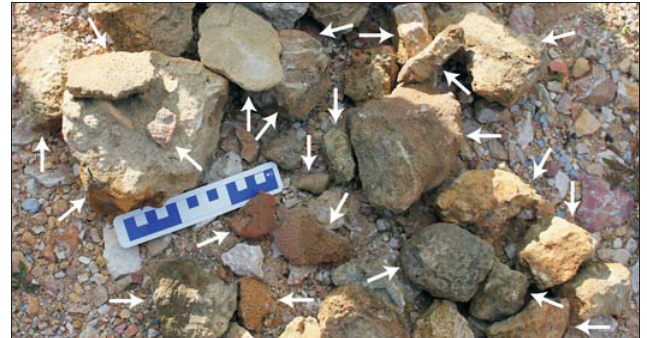
Fig. 3. Bulk collection of Eocene sponges at Lovara Quarry. Some of the sponge specimens are indicated by white